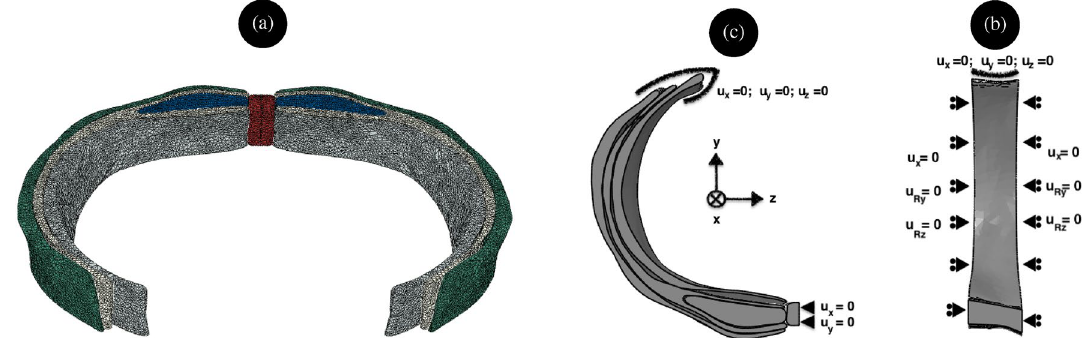
Figure 2. ( a ) Representation of the finite element mesh ( b ) top view of the AW subdomain with boundary conditions, and ( c ) side view of the AW subdomain with boundary